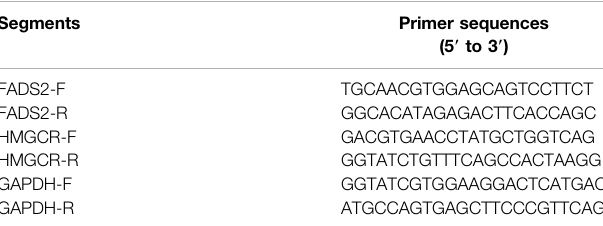
TABLE 2 | Primer sequences for real-time